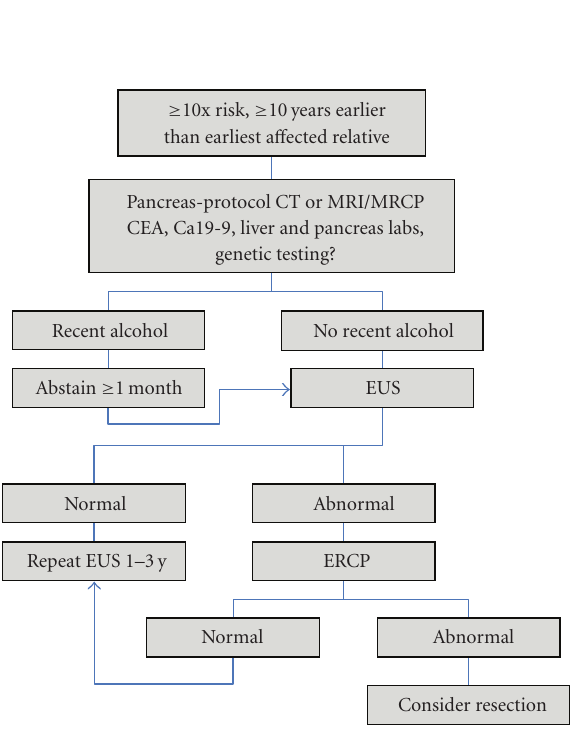
Figure 1: Flow chart for pancreatic cancer screening in high-risk